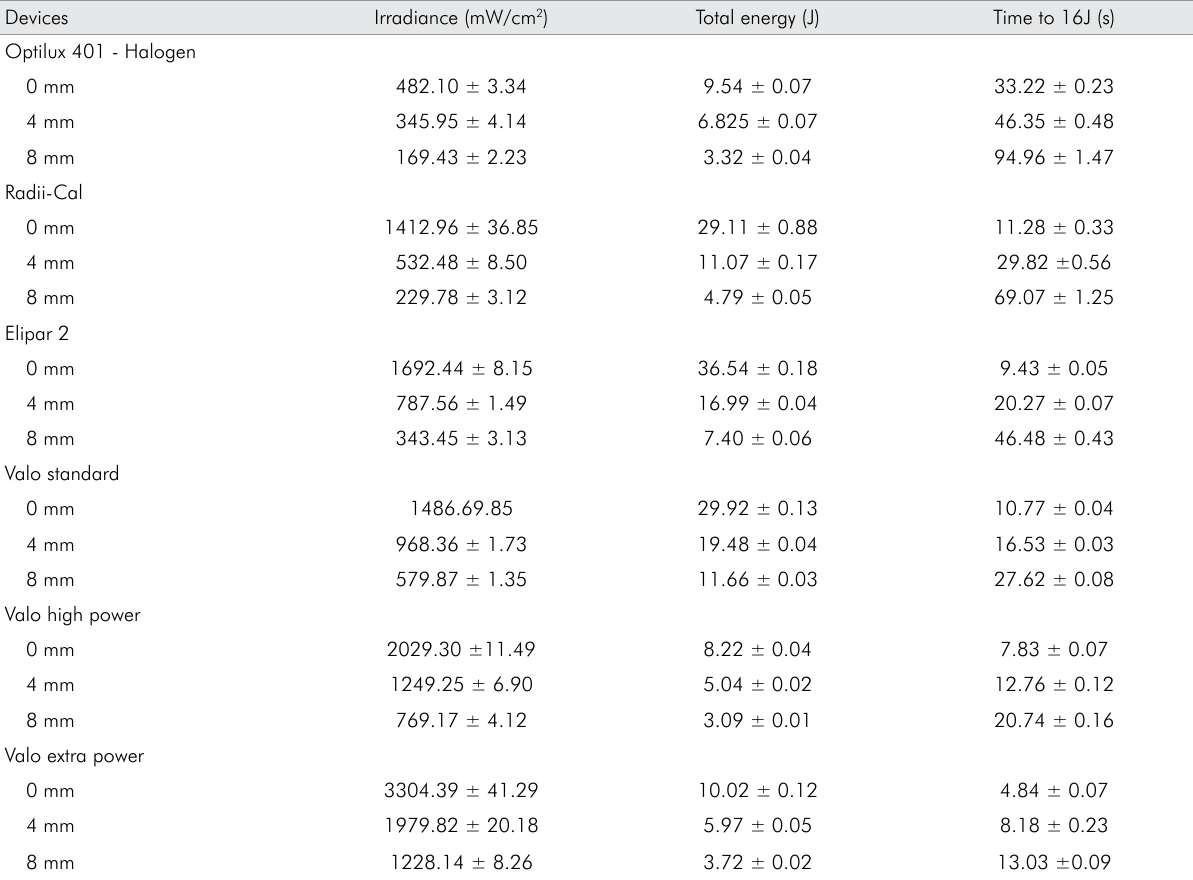
Table 1. Means and standard deviations of irradiance (mW/cm2), total energy (J) and time necessary to achieve 16J (s).